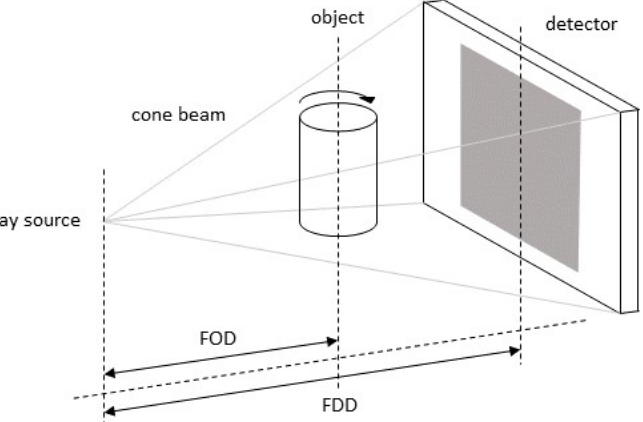
Figure 3. Acquisition of a radiographic image in cone beam X-ray CT: The emitted X-ray radia- tion of a point-like source, attenuated by passing through an object, is measured as intensity in a pixelated